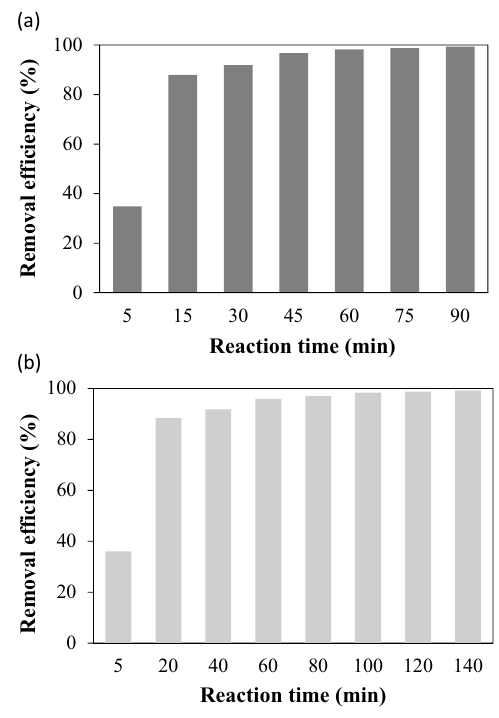
Figure 6: E ff ect of reaction time on the removal e ffi ciency of ( a ) MO and ( b ) MB. MO: initial pH 7.0, catalyst dosage = 100 mg · L − 1 , [ H ] = 0.2mol · L − 1 , initial [ MO ] = 10mg · L − 1 , and ambient temperature. 2 O 2 MB: initial pH 3.0, catalyst dosage = 50mg · L − 1 , [ H 2 O 2 ] = 0.1mol · L − 1 , initial [ MB ] = 10mg · L − 1 , and ambient